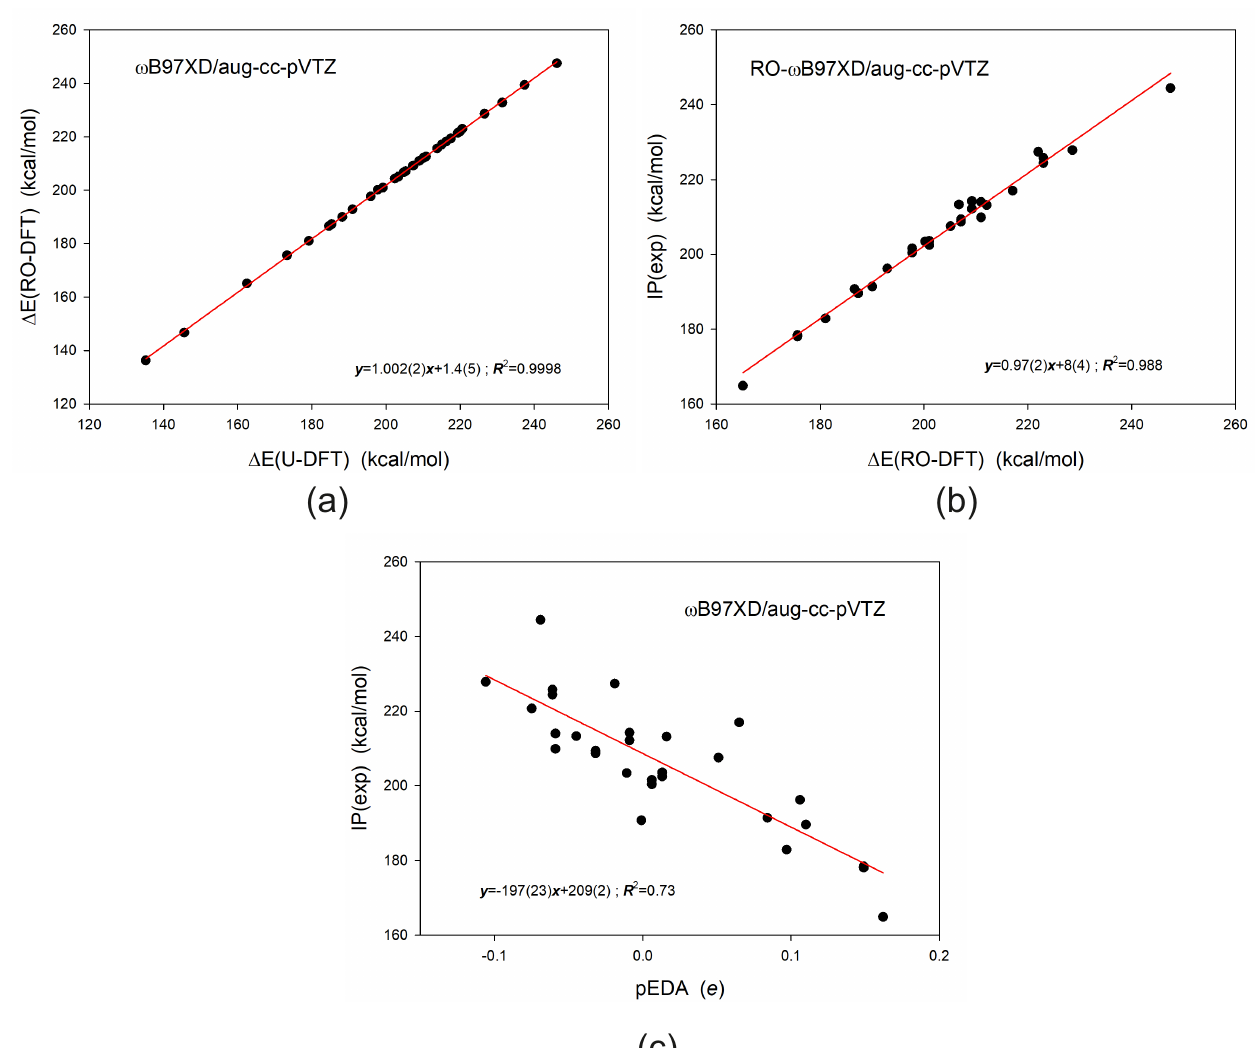
Figure 1. ( a ) The total energy differences ∆ E (kcal/mol) of the monocation radicals of monosubstituted benzenes cal- culated using the U- and RO-DFT approximations referring to the ground singlet state total energies calculated using the R-DFT method. ( b ) Linear correlations between experimental ionization energies and the relative values of total energies ( ∆ E, kcal/mol) of monosubstituted benzene monocation radicals calculated using RO-DFT approximations and the ω B97XD/aug-cc-pVTZ level, referring to the energies of the molecules in the ground singlet state calculated at the same level. ( c ) Weak linear correlations between experimental ionization energy and the pEDA substituent descriptor reflecting substituent influence on the benzene π -electron system in the ground state. All IP(exp) values (Table 1) were considered in plots ( b , c